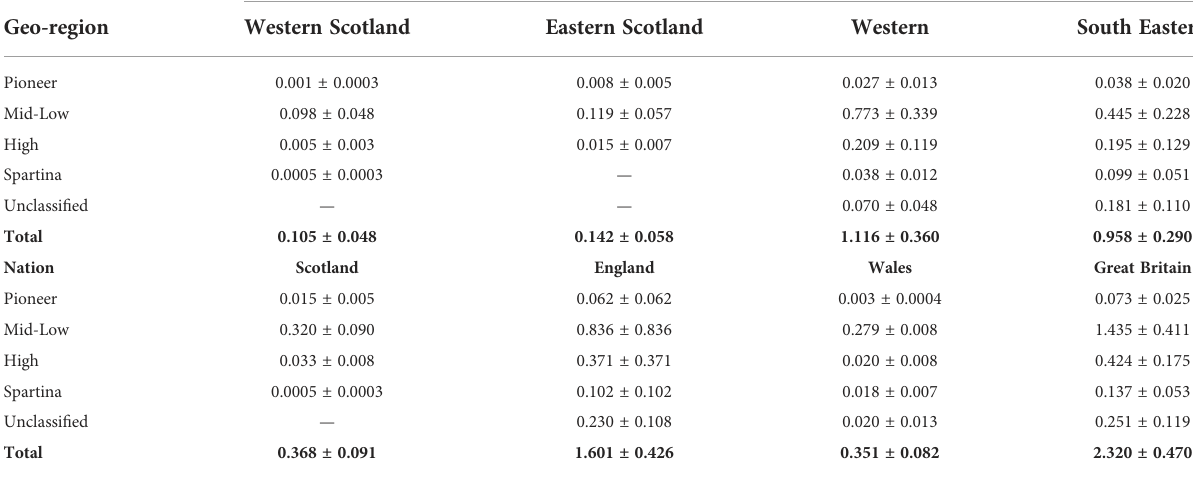
Sur fi cial (top 10cm) soil OC stock (Mt)